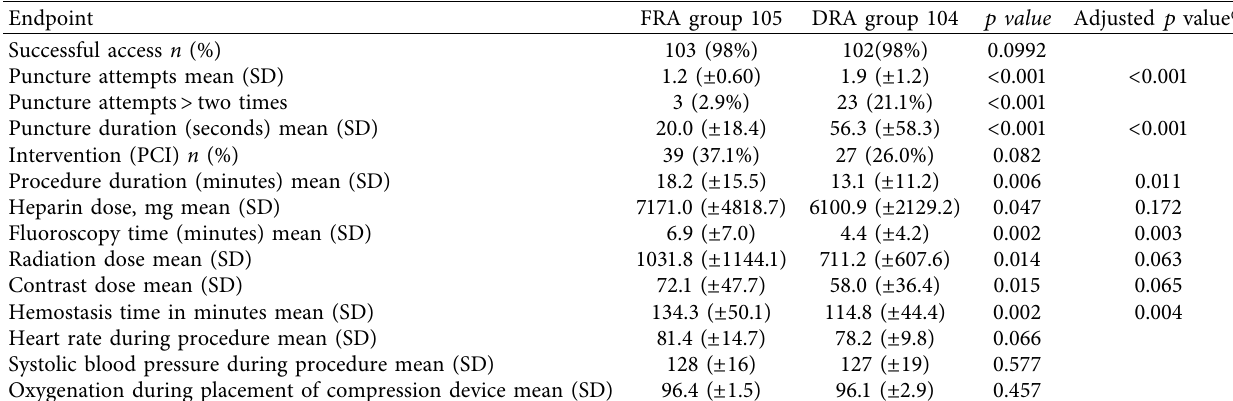
Table 2: Procedure data and study endpoints.